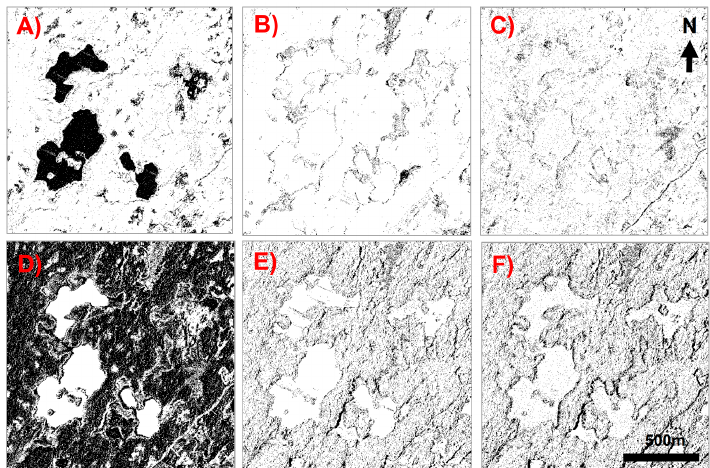
Figure 12. Five outcomes from the decision tree classifier and the LiDAR only additional statement showing the spatial extent of the sensor agreement from 2 April 2016. Black pixels represent areas where outcome occurred, white pixels represent areas where outcome did not occur: ( A ) All agree;